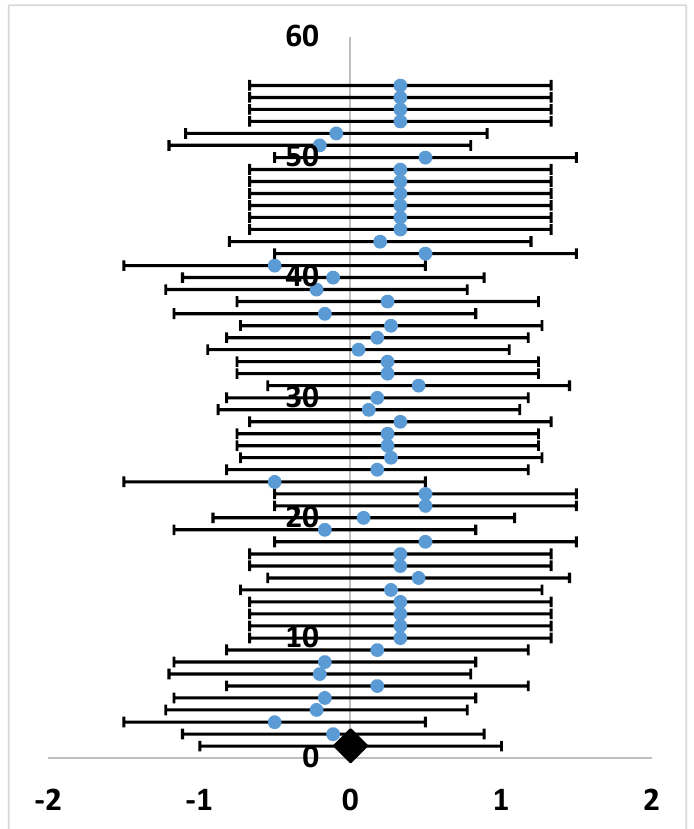
Figure 3. Forest plot of grasshopper preferences for introduced plants by study. Random effects model: (I 2 = 0%). Blue dots and horizontal bars represent data for the preference metric and 95% confidence intervals, respectively. The black diamond represents the summary effect. The studies and effect sizes are presented on the Y-axis and X-axis, respectively. Outcomes, 95% confidence intervals, and sample sizes for 55 studies included in the meta-analysis are provided in the supplementary material (Tables S4 and S5).